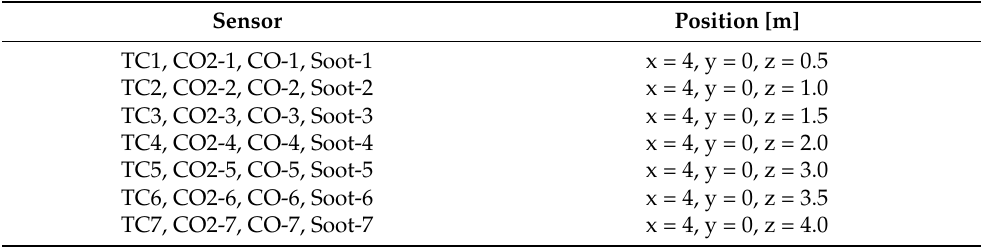
Figure 3. The geometry of the pet-coke burner. Table 1. Sensors locations inside the